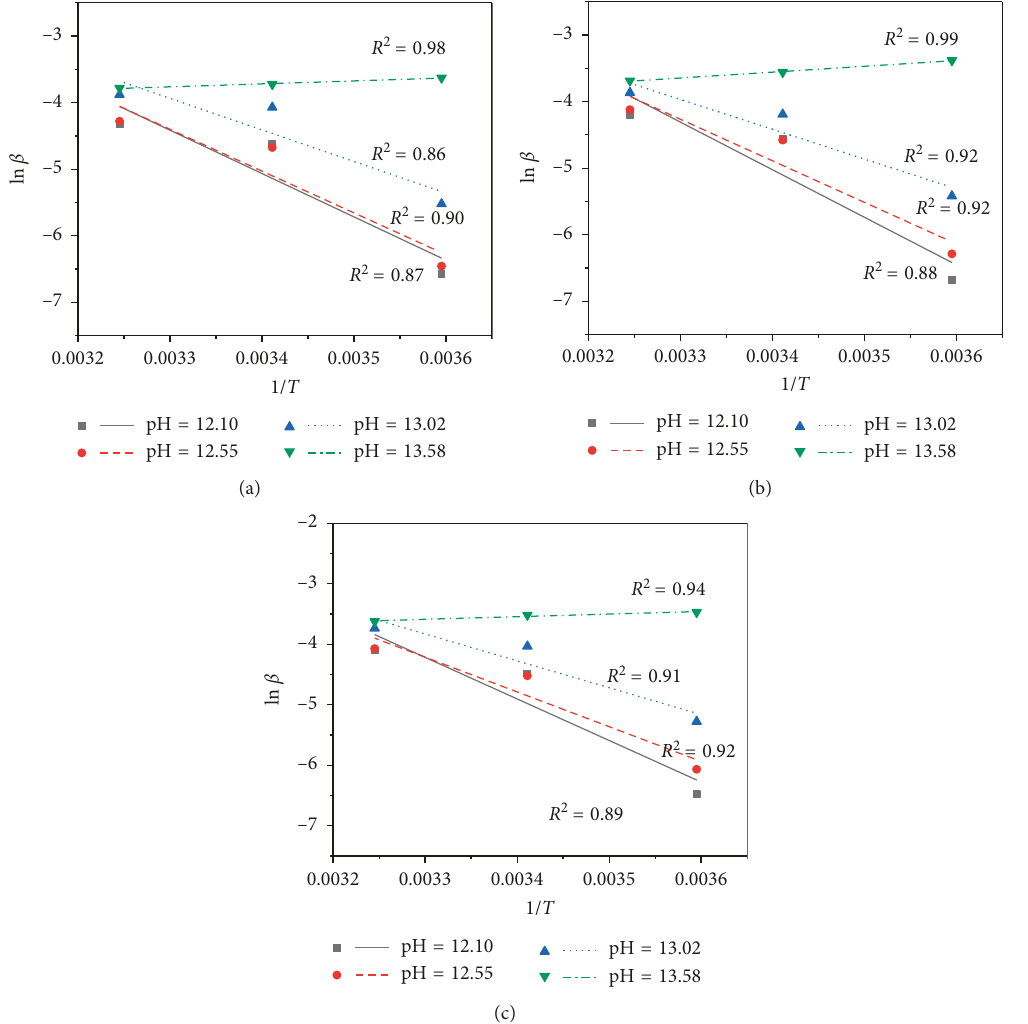
Figure 6: Effect of curing temperature on the hydration rate β at different w/s ratios for 14 days: (a) w/s (c) w/s 0.6. (cid:31) Table 2: Apparent activation energy E